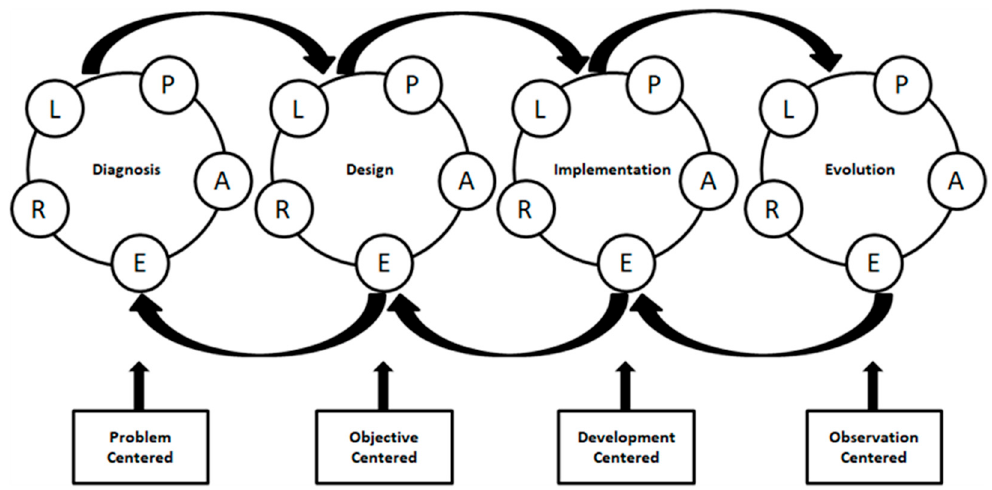
Figure 2. Action design research-process model with research entry points [1].